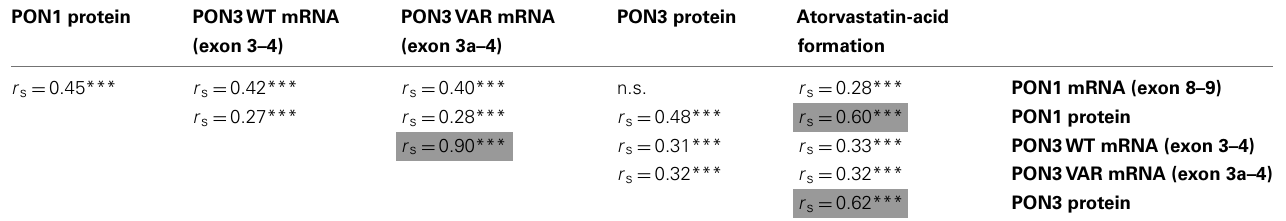
Table 3 | Correlation analyses of PON1 and PON3 expression and microsomal atorvastatin-lactone hydrolysis.